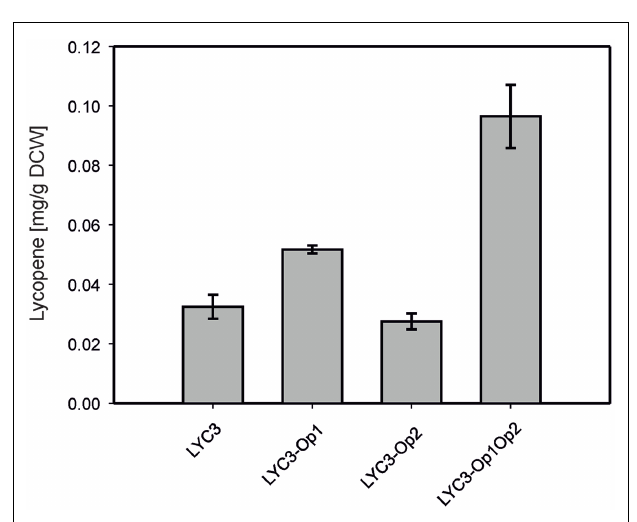
FIGURE 2 | Lycopene production by C. gluamicum LYC3 and derived strains expressing the synthetic ispDFE operon (LYC3-Op1), the synthetic dxr-ispGH operon (LYC3-Op2) or both operons (LYC3-Op1Op2) for overproduction of MEP pathway enzymes . Cells were grown in glucose CGXII minimal medium. Means and standard deviations of three cultivations are shown.